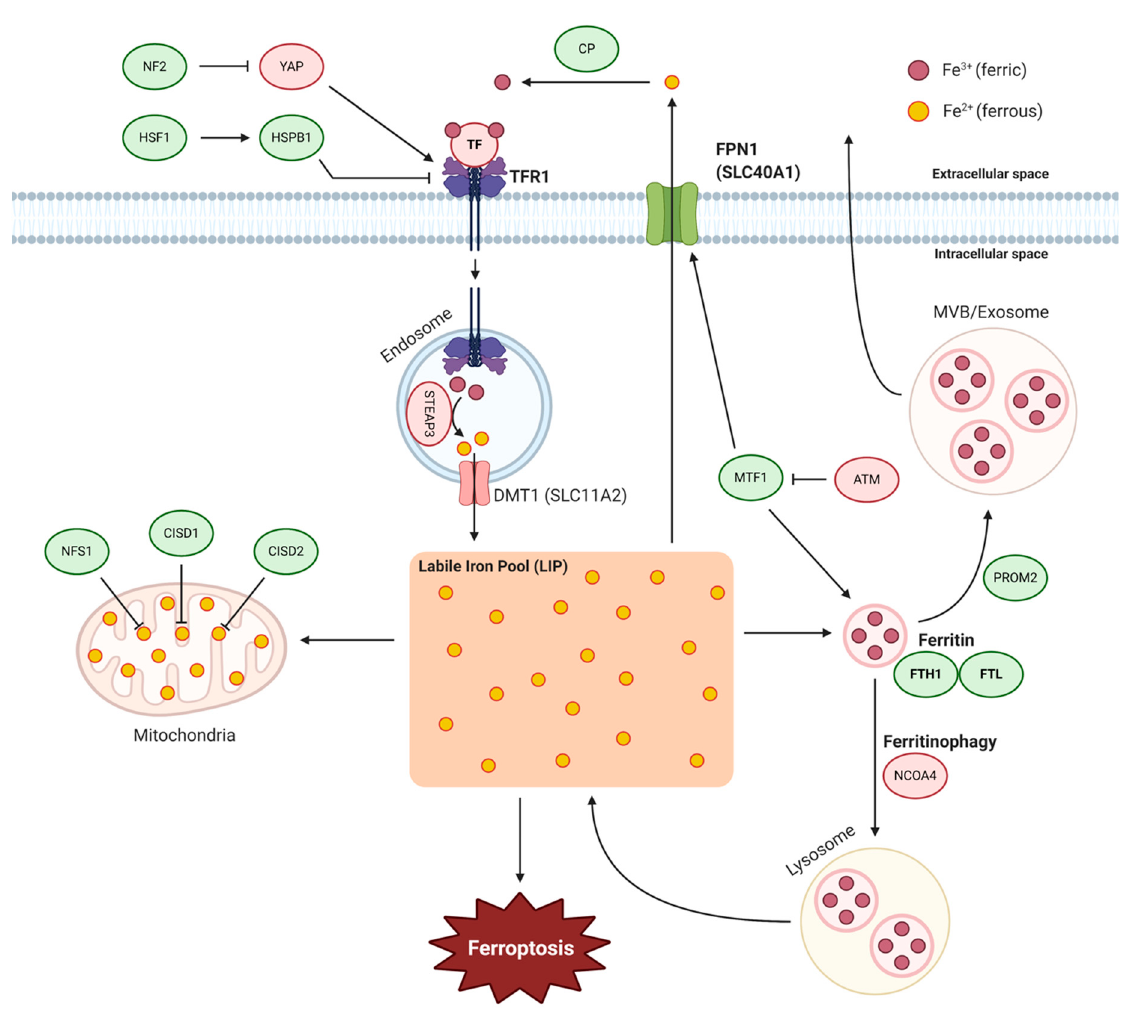
Figure 1. Iron metabolism regulates ferroptosis. Ferric iron (Fe 3+ , red circle) bound to TF can form a complex with TFR1 to be endocytosed into cells. In the endosome, ferric iron is reduced to ferrous iron (Fe 2+ , yellow circle) by STEAP3 and transported into the cytoplasm by DMT1 or SLC11A2. Ferrous iron is stored in ferritin heteropolymers to protect cells and tissues from iron-mediated damage. Ferritin can undergo ferritinophagy, an autophagic degradation process, or exported out of the cell as MVB/exosomes. In the mitochondria, iron-sulfur clusters can be used by iron-sulfur proteins in various processes. Dysregulation in any of the above processes can lead to an increase in the labile iron pool and contribute to ferroptosis. Ferroptosis inhibiting and inducing factors are indicated in green and red, respectively. (Abbreviations: ATM, ATM serine/threonine kinase; CISD1/2, CDGSH iron-sulfur domain-containing protein 1/2; CP, ceruloplasmin; DMT1,